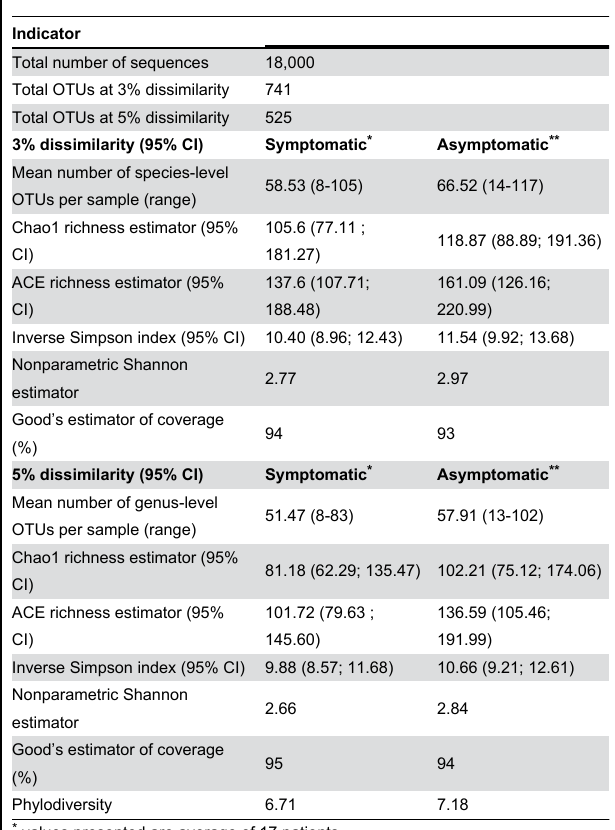
Table 2. Sequencing data and diversity and richness estimate calculations for bacterial taxa in secondary/ persistent endodontic infections with periradicular